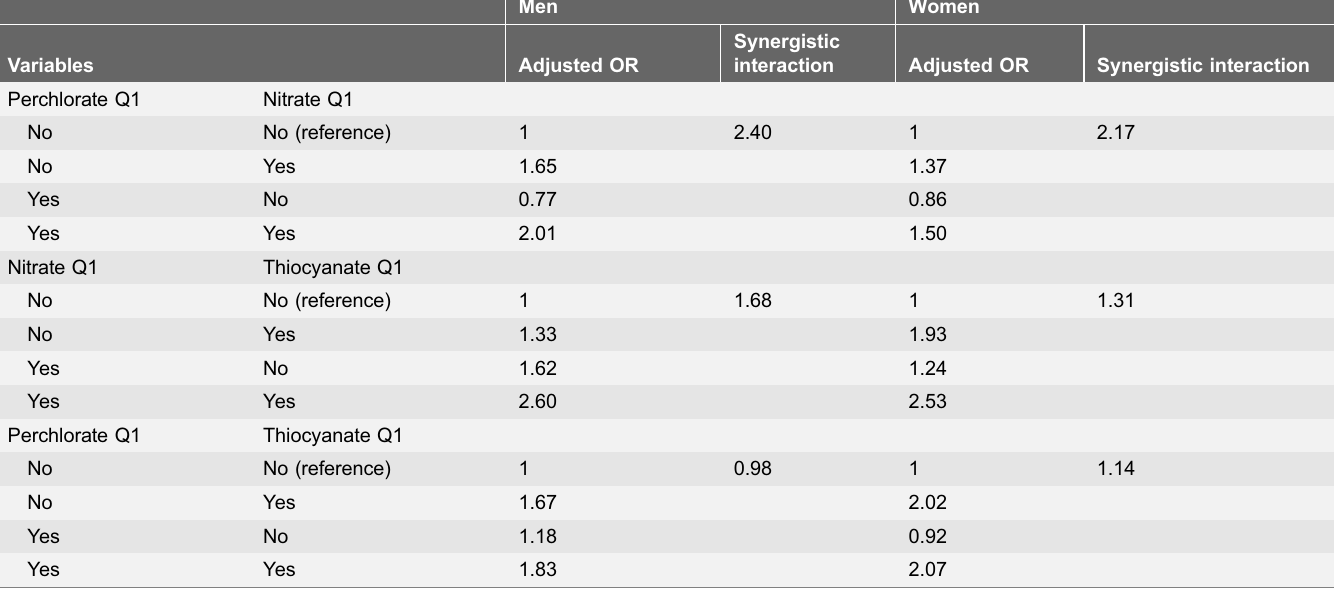
aldosteronism [24]. Expression of the angiotensin II type I receptor and the mineralocorticoid receptor has been identified in normal parathyroid glands and found to be increased in adenomatous parathyroid glands [25]. These findings are consistent with the observation that in the general population, a high aldosterone- to-renin ratio was associated with high serum PTH concentrations [26]. Table 7. Synergistic interaction between creatinine-corrected urinary concentrations of perchlorate, nitrate, and thiocyanate in influencing hyperparathyroidism (defined as parathyroid hormone . 70 pg/mL) among the United States adults, NHANES 2005–2006. Men